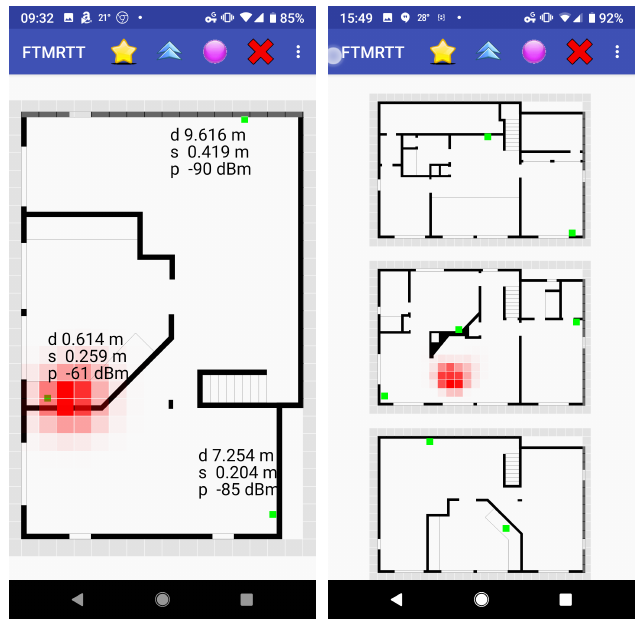
Figure 11. Sample “heat maps” of Bayesian grids. Left: 2-D case (single level) with 3 responders (green dots). Text shows current FTM RTT distance, st. dev. and signal strength. Right: 3-D case (three levels) with 7 responders. Voxels in each floor were collapsed into a single layer for display